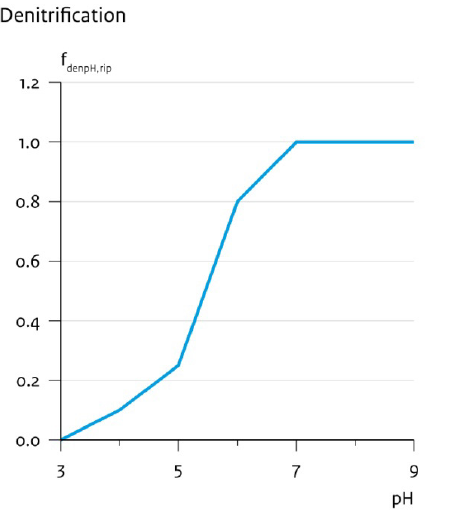
Figure 5. Reduction fraction ( f denpH , rip ) of riparian denitrification as a function of soil pH modified from Bouwman et al.